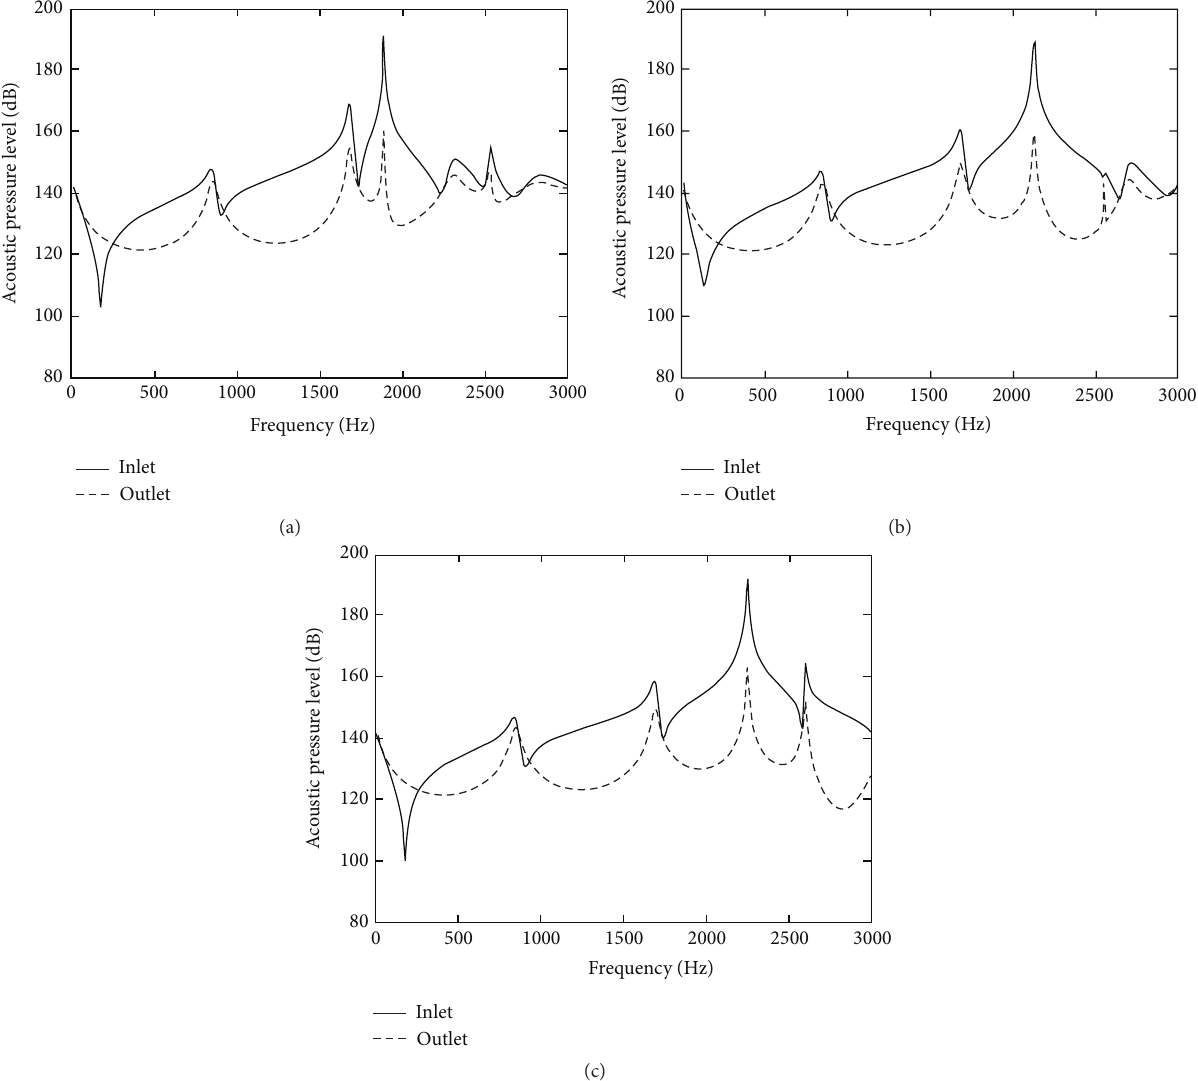
Figure 10: Acoustic pressure level for the inlet and outlet of the straight-through perforated pipe silencers: (a) silencer 𝑃 1 , 𝑀 = 0.1 , (b) silencer 𝑃 2 , 𝑀 = 0.2 , and (c) silencer 𝑃 3 , 𝑀 = 0.1